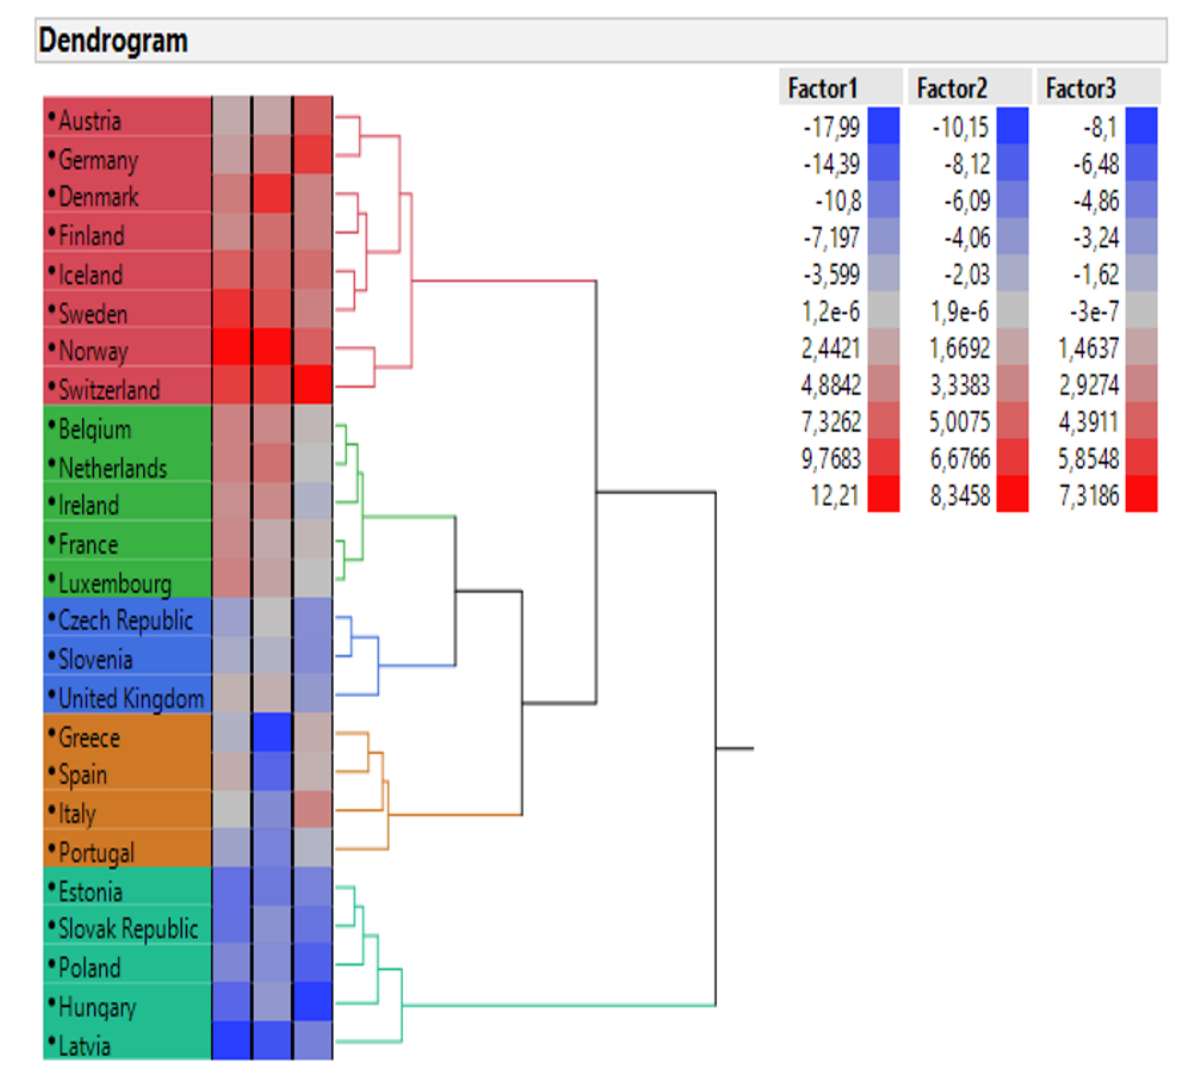
Figure 6. Dendrogram of the European countries clusters according to extracted